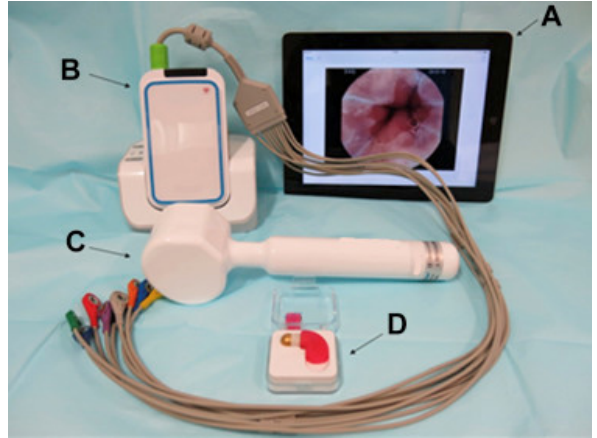
Figure 2. The MiroCam Navi system. ( A ) real-time viewer; ( B ) sensor and receiver; ( C ) hand-held magnet; ( D ) MiroCam Navi capsule. Adapted from Rahman et al. [19] with permission from